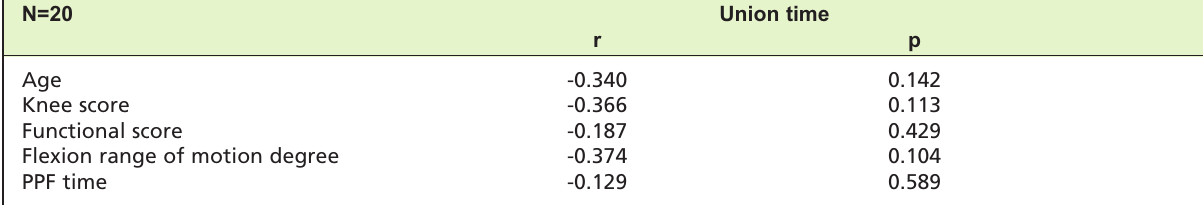
Spearman’s Correlation Coefficient between Age, Knee score, Functional score, Flexion range of motion degrees, Table II: PPF time and Union